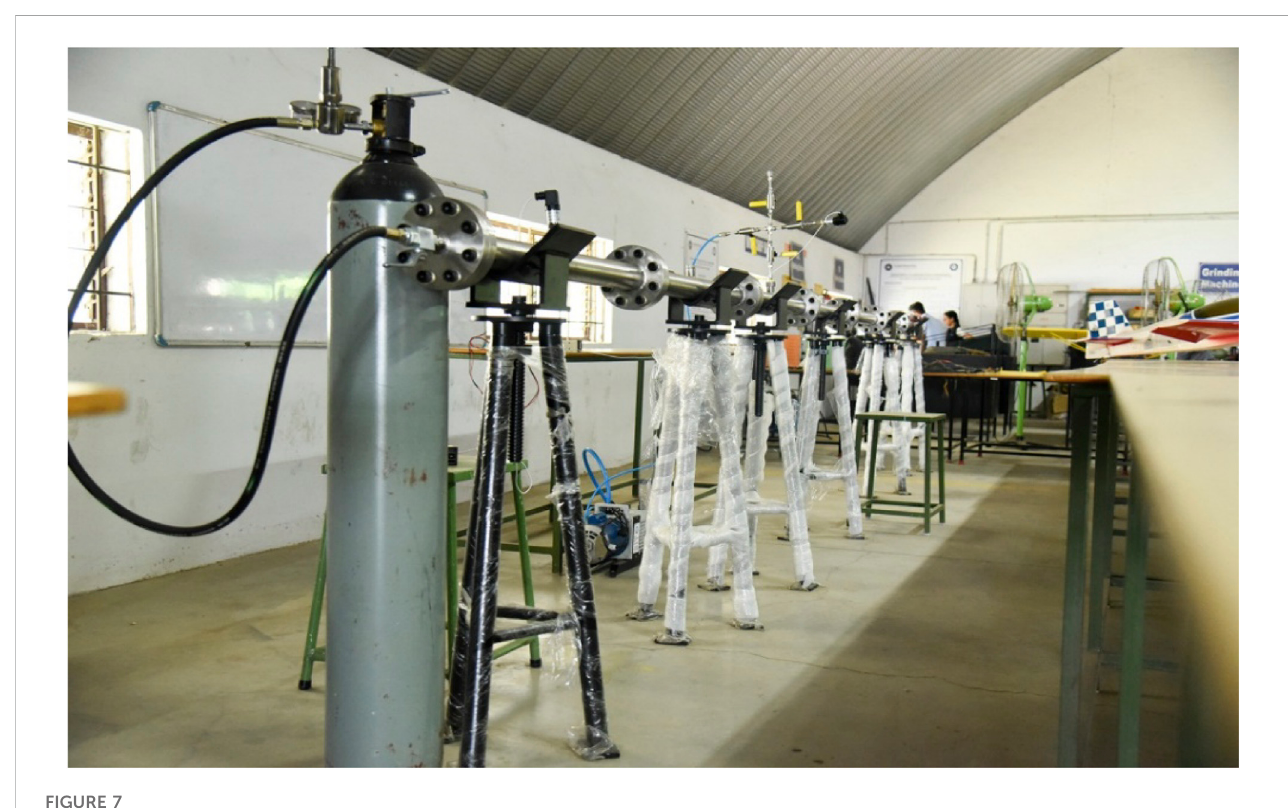
Test setup for high pressure load development.